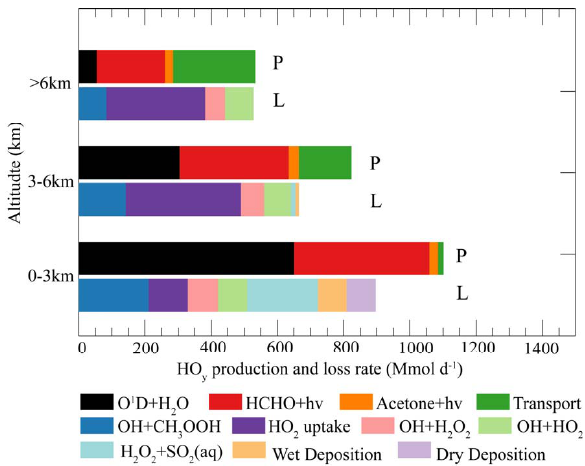
Figure 6 Circumpolar GEOS-Chem model budget of HO y for the Arctic tropospheric Fig. 6. Circumpolar GEOS-Chem model budget of HO y for the column (60-90N) during ARCTAS (1-21 April 2008). Mean production rates (P) and loss rates (L) are shown for three altitude bands. The transport term describes exchange with Arctic tropospheric column (60–90 ◦ N) during ARCTAS (1–21 northern mid-latitudes south of 60N. April 2008). Mean production rates ( P ) and loss rates ( L ) are shown for three altitude bands. The transport term describes ex- change with northern mid-latitudes south of 60 ◦ N.